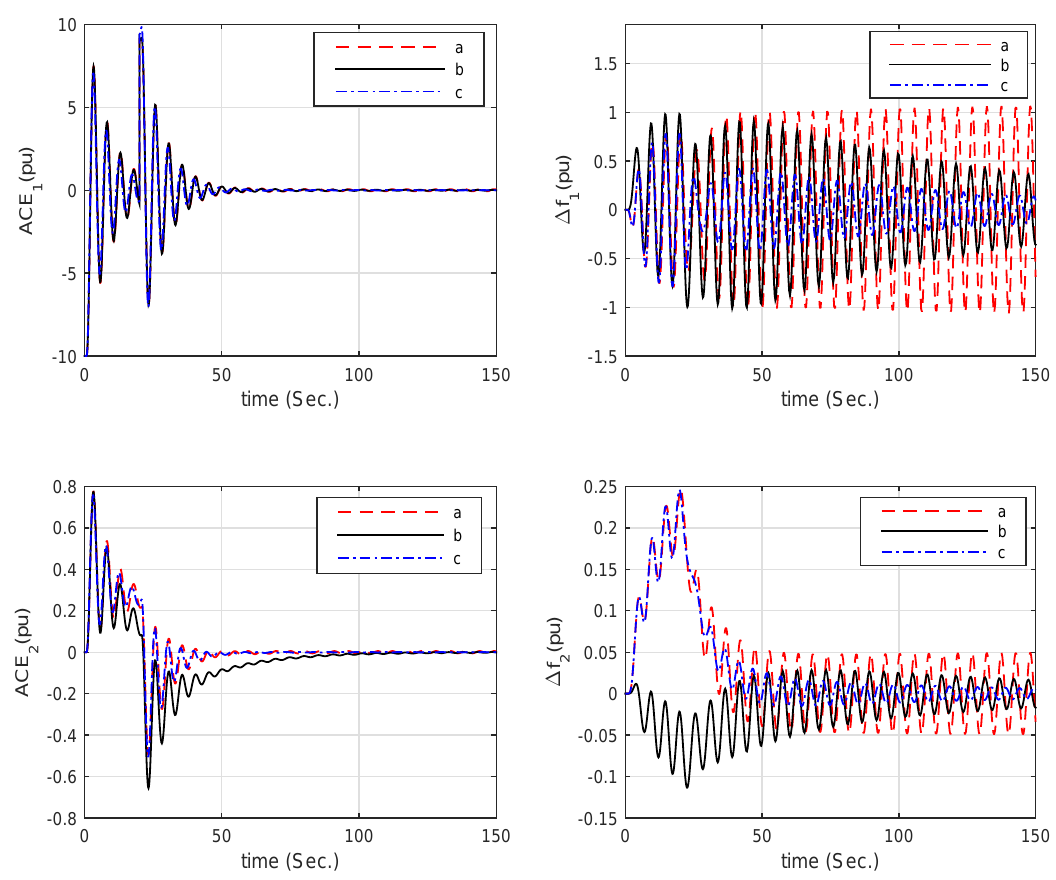
Figure 9. Frequency deviation and control error responses of two-area deregulated LFC scheme with K I = 1, h 1 ( t ) = 0 and different K P , h 2 ( t )